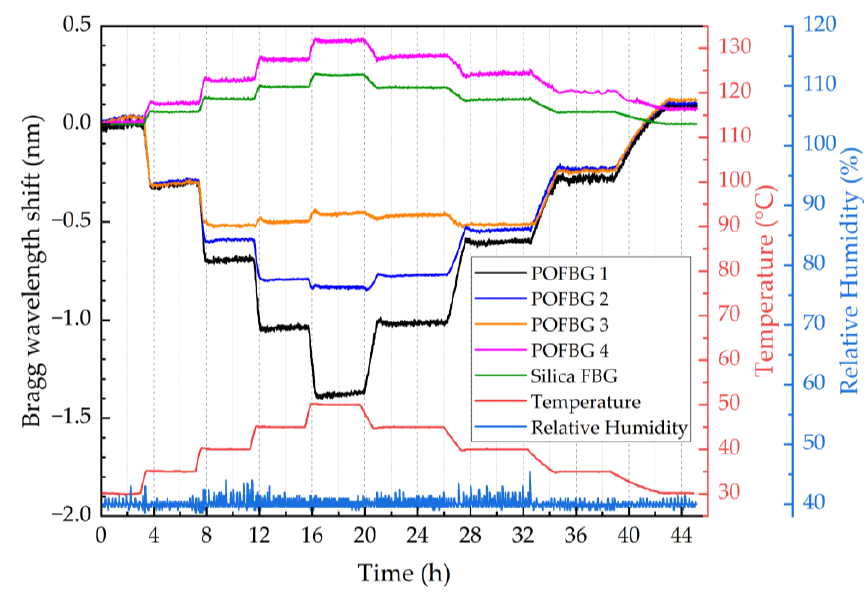
Figure 11. Temperature response of sensors over time.